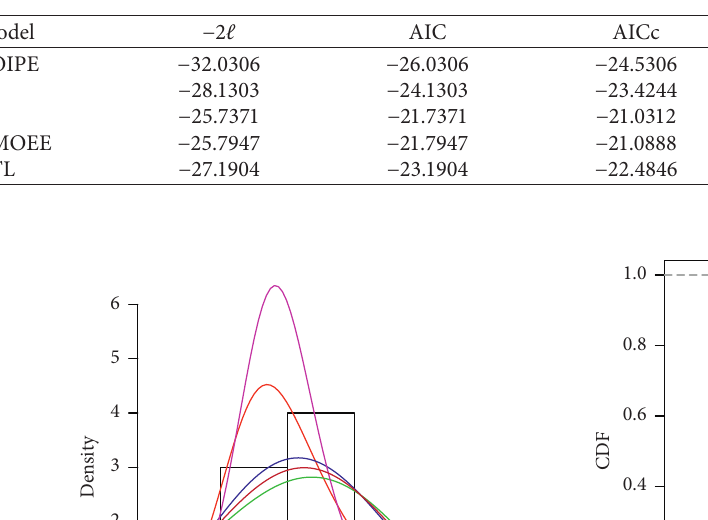
Table 7: Goodness-of-fit statistics for data II.